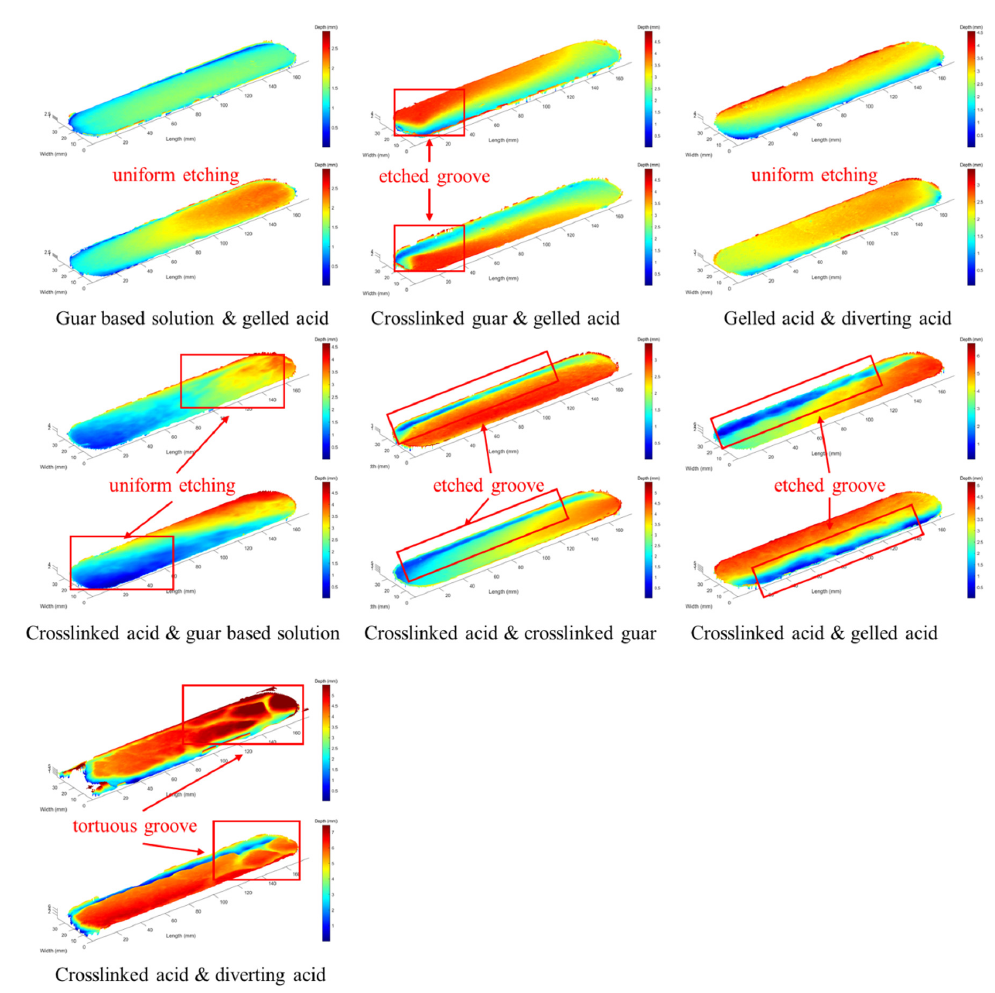
Figure 5. Surface scan of slabs after acid